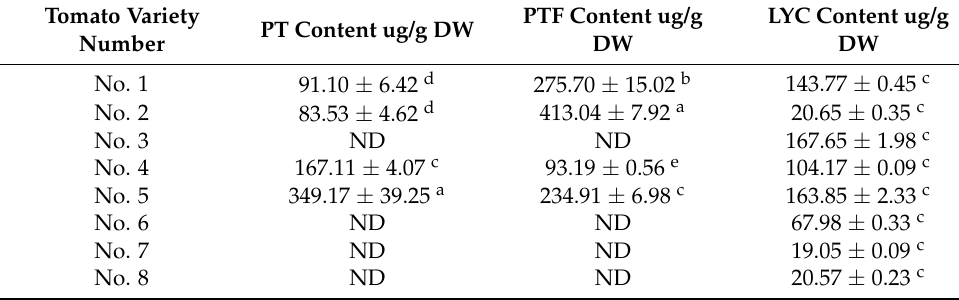
Table 2. The content of PT, PTF and LYC in 17 tomato